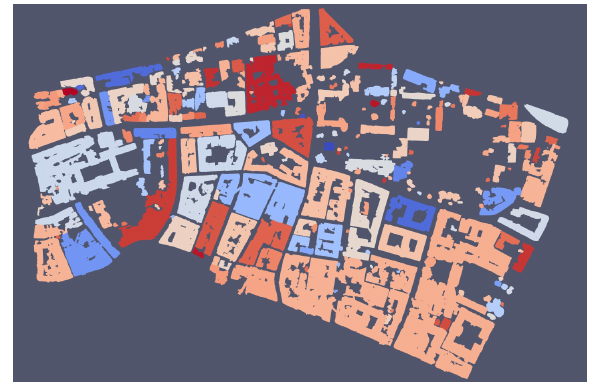
Figure 3. The results of building segmentation : Each of the buildings are marked in a single color. It can be seen that noise is present in the results as small entities (primarily trees). Multiple buildings may be identified as one when some joining element is present (i.e., bridge or a tree in